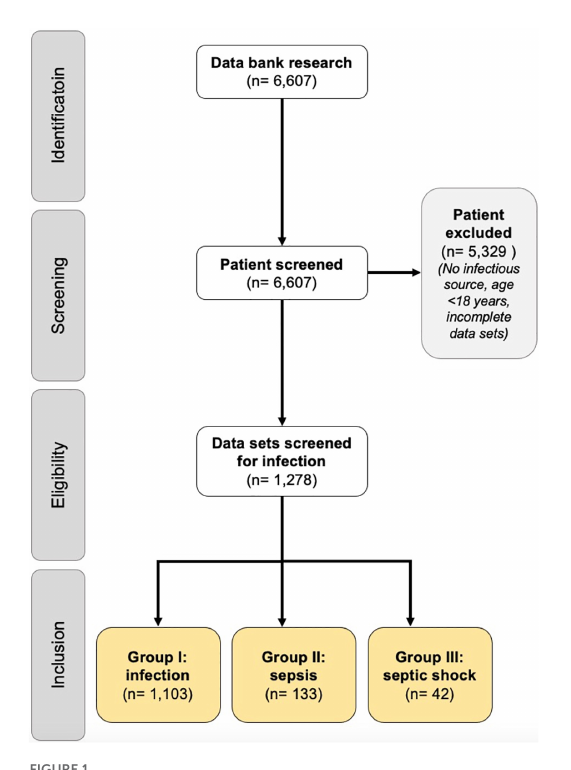
FIGURE1 Prisma chart. A total of 6,607 patients were detected from the patient management system database as a potential study population. These 6,607 patients were screened for inclusion and exclusion criteria, resulting in the inclusion of 1,278 patients with documented infection focus. A total of 5,329 patients had to be excluded from the study because of relevant exclusion criteria (e.g., age < 18 years. Incomplete records, no infection focus). The study population of 1,278 patients was divided